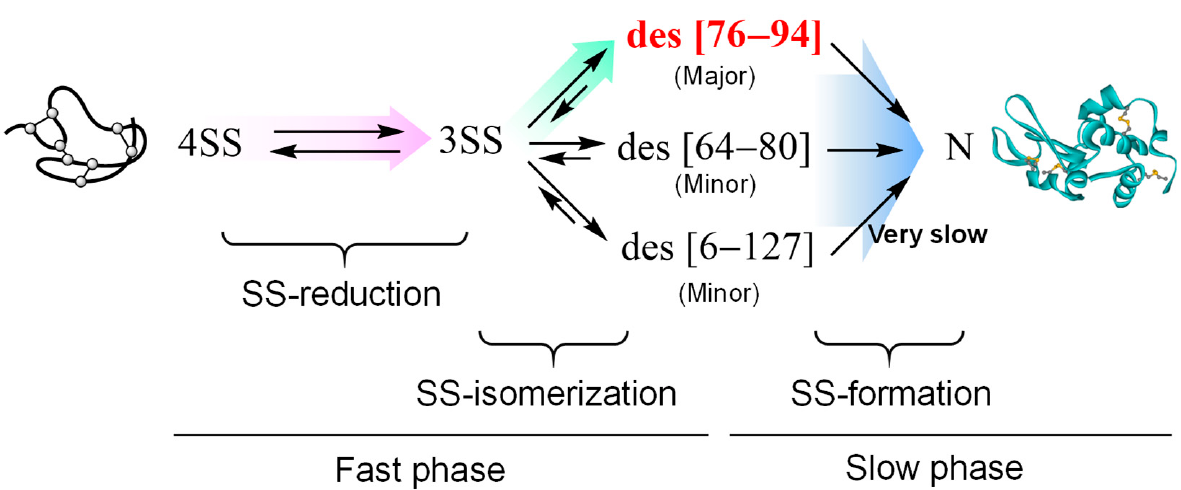
Figure 7. Putative major refolding pathways of scrambled HEL (4SS) to N at physiological temperature.